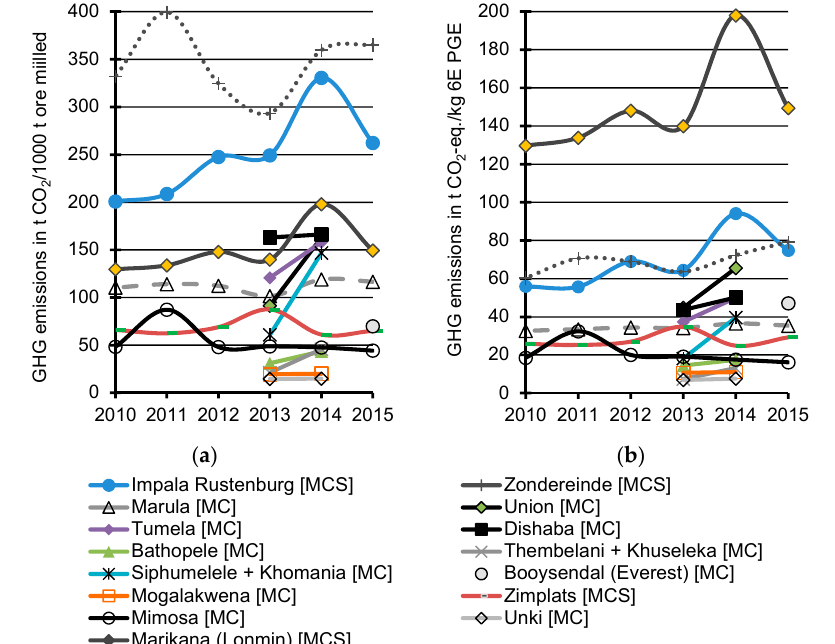
Figure 8. GHG emissions (Scope 1 and 2): per t ore milled ( left axis ); and per kg 6E PGE ( right axis ). Based on data from [15,54–84].